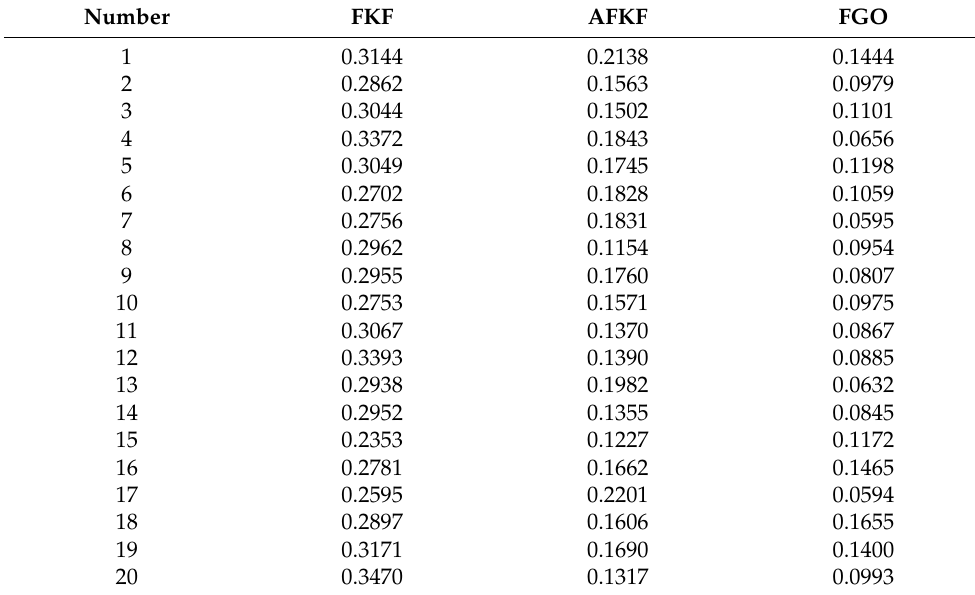
Table 5. The MAE values of position errors (m) in 20 groups of Monte Carlo simulation experiments for the three algorithms (FKF, AFKF, and